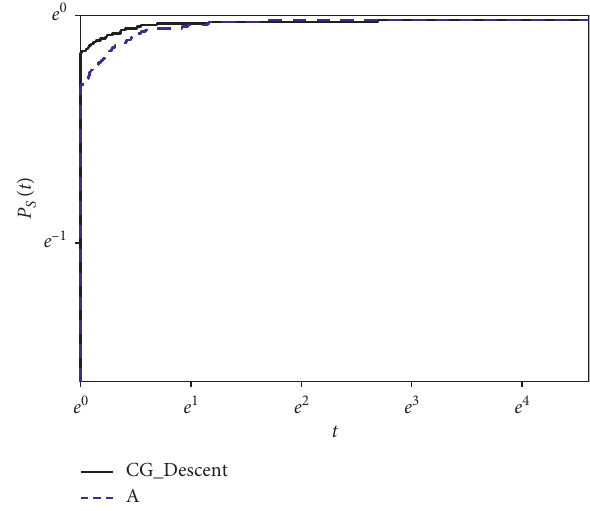
Figure 2: Performance measure based on the CPU time.